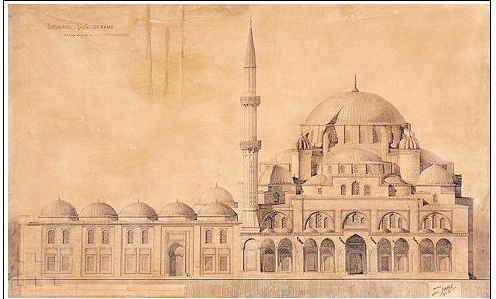
Figure 3. An example of old architectural survey of Şehzade Mosque hand drawn by Arch. Ali Saim Ülgen from early 1960s.